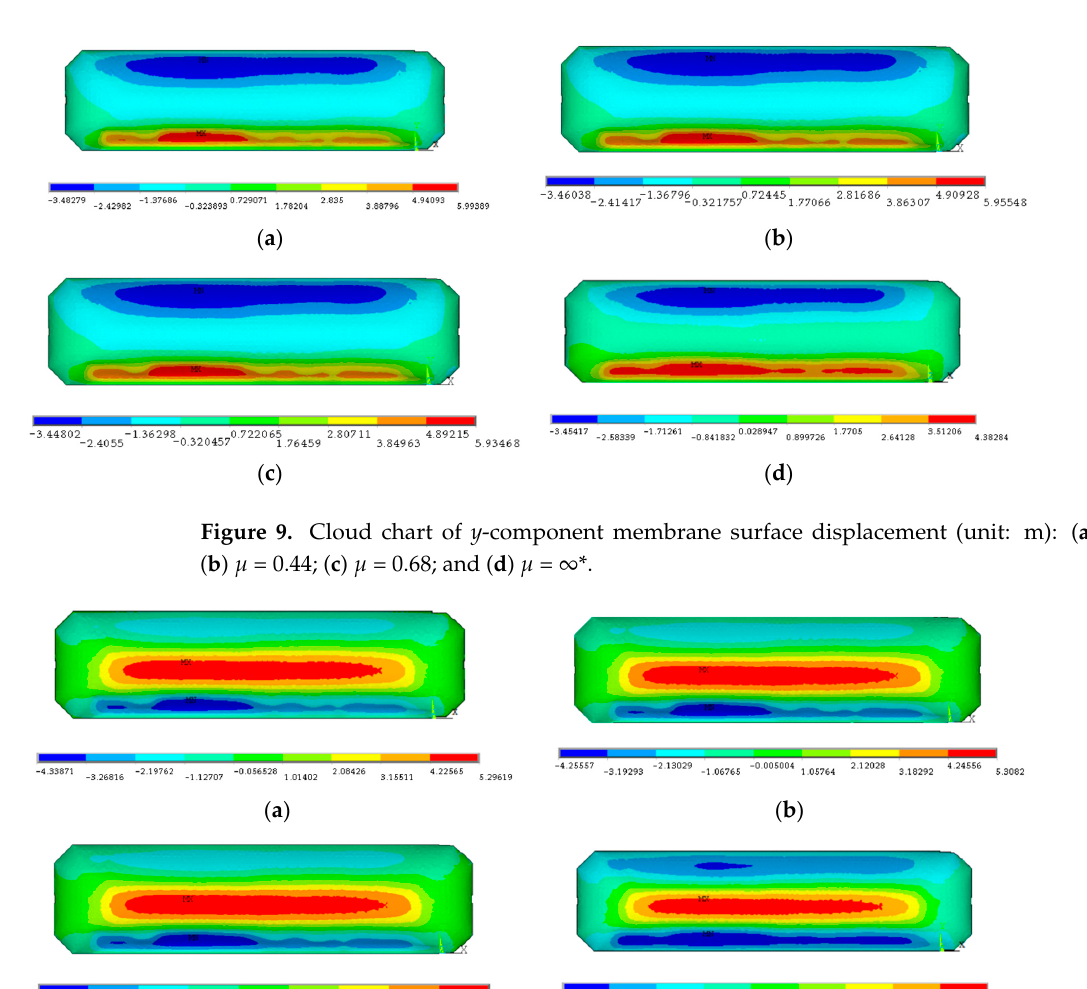
Figure 8. Cloud chart of x -component membrane surface displacement (unit: m): ( a ) μ = 0.2; ( b ) μ = 0.44; ( c ) μ = 0.68; and ( d ) μ = ∞ *.